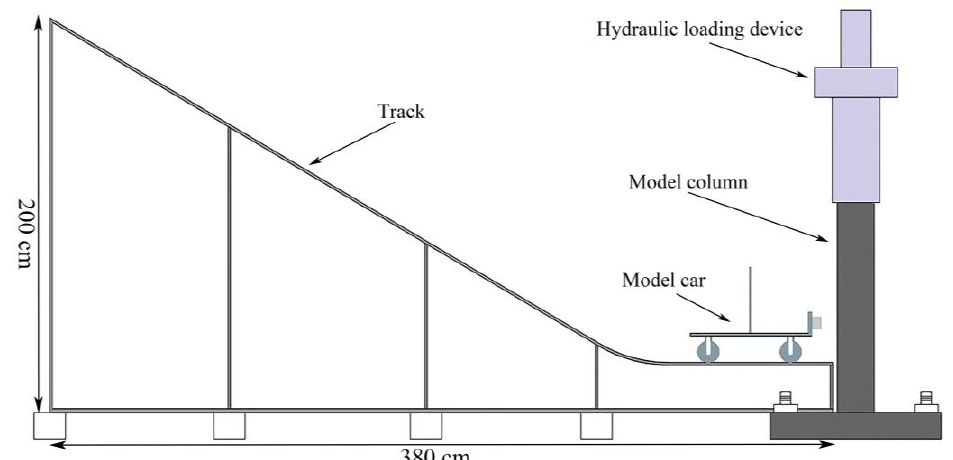
Figure 3. Schematic diagram of the experimental facility.